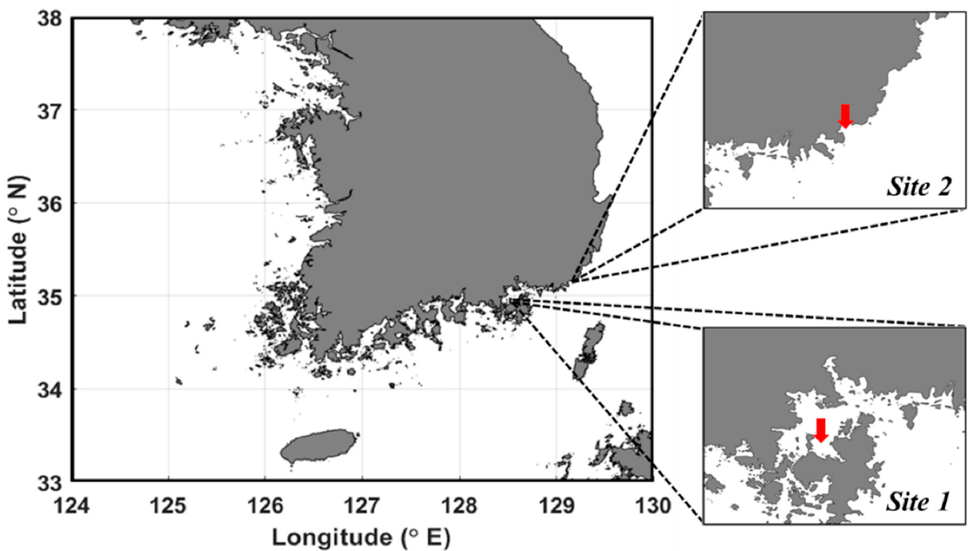
Figure 1. Sea experiment area. The red arrows indicate the detailed locations.